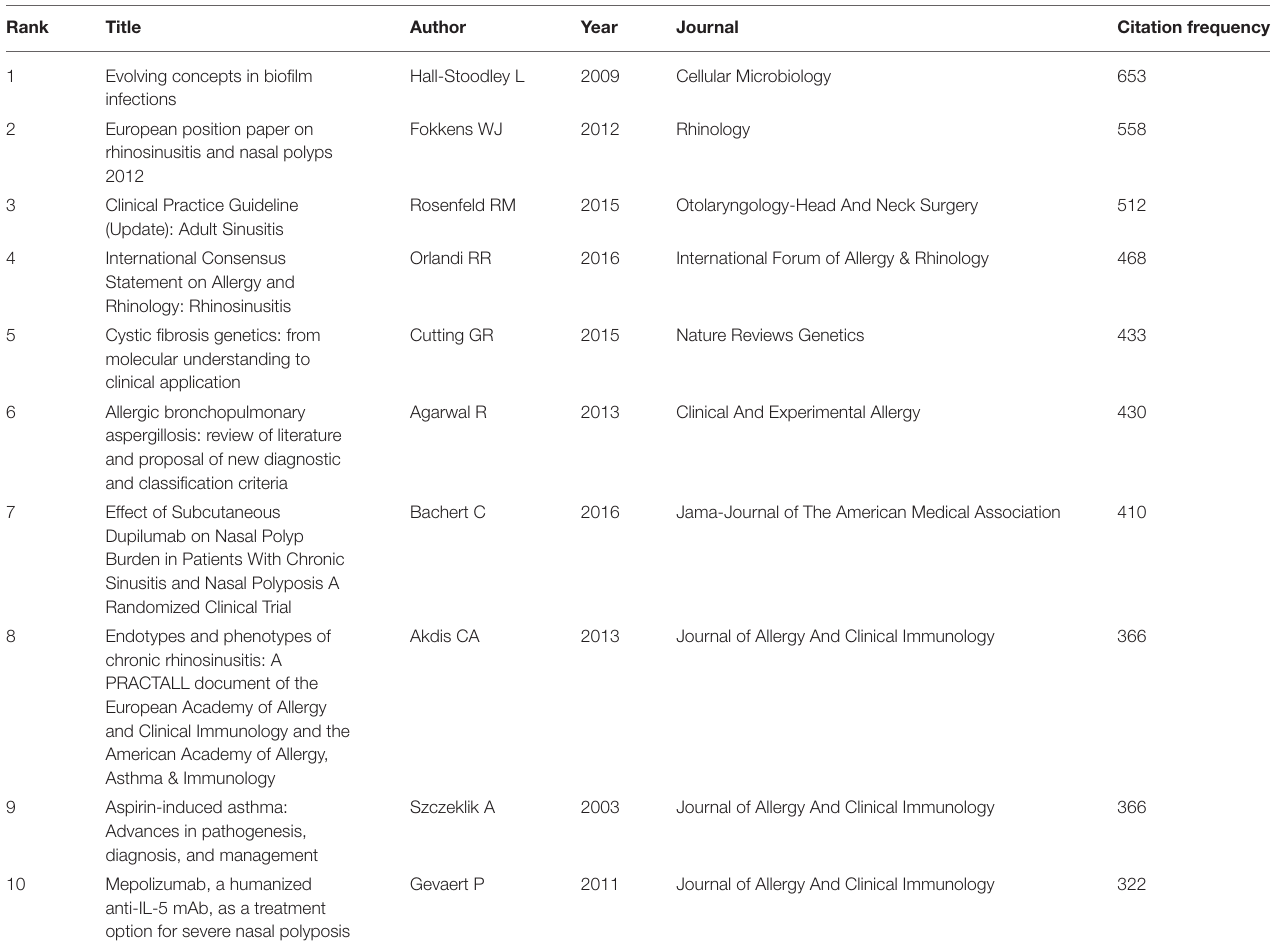
TABLE 5 | Top-10 most co-cited references on CRS-treatment research from 2001 to